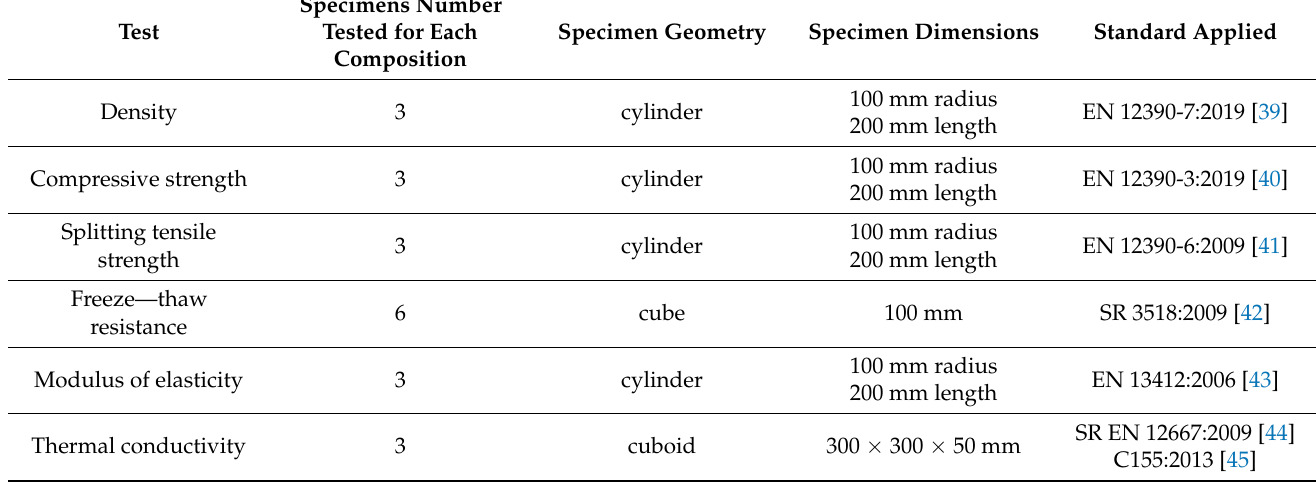
Table 1. Performed tests